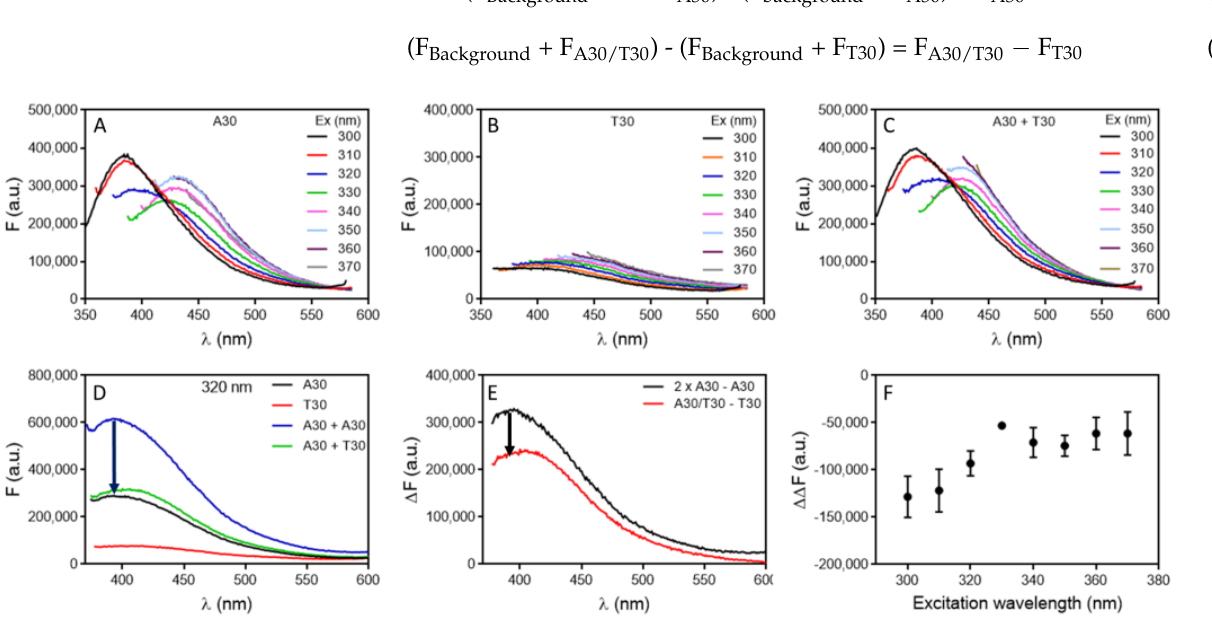
Figure 1. The fluorescence emission spectra of 5 μM ( A ) A30, ( B ) T30 and ( C ) annealed A30/T30 duplex excited at different wavelengths in buffer (10 mM PB, pH 7.0, 100 mM NaCl). ( D ) Comparison of fluorescence emission spectra of various DNA samples excited at 320 nm. ( E ) The fluorescence difference spectra: (2 × A30 − A30) and (A30/T30 − T30) with 320 nm excitation. ( F ) The difference of the difference spectra (the red line minus black line) in ( E ) at various excitation wave- lengths.